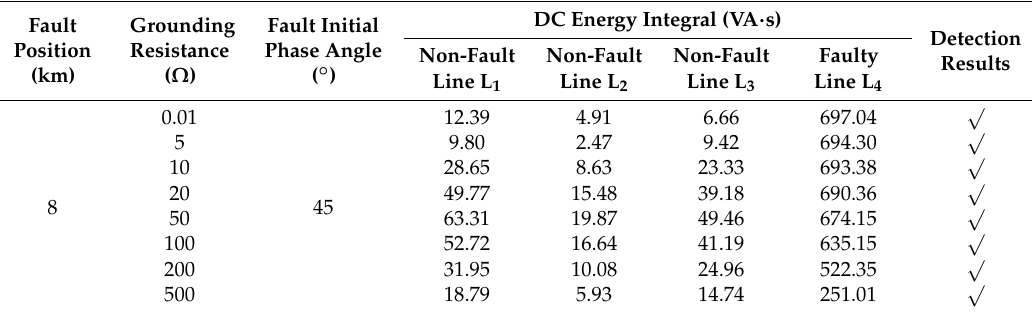
Table 7. DC energy integral under SPG faults with different grounding